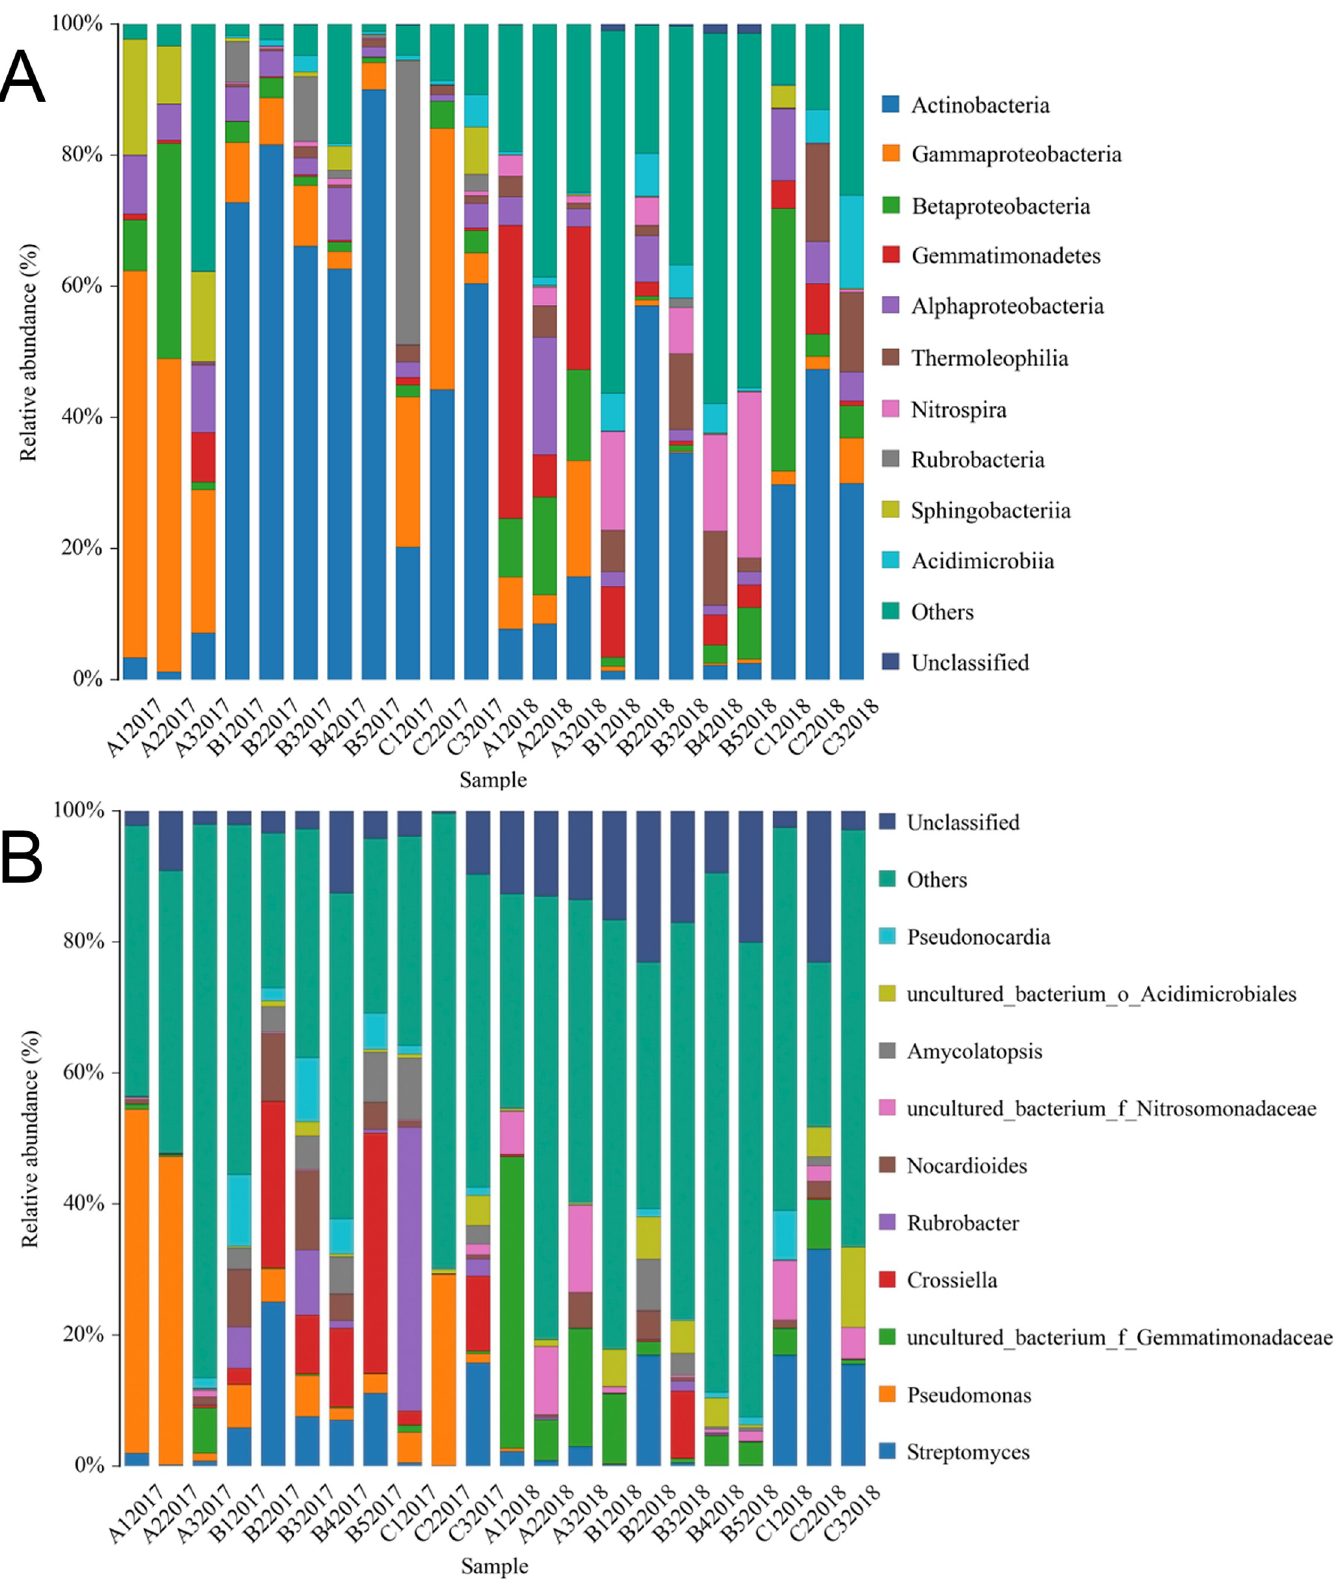
Fig 2. Distribution patterns of bacteria in 2017 and 2018 at the phylum (A) and genus (B) level in all 22 samples. https://doi.org/10.1371/journal.pone.0236165.g002 PLOS ONE | https://doi.org/10.1371/journal.pone.0236165 July 22,